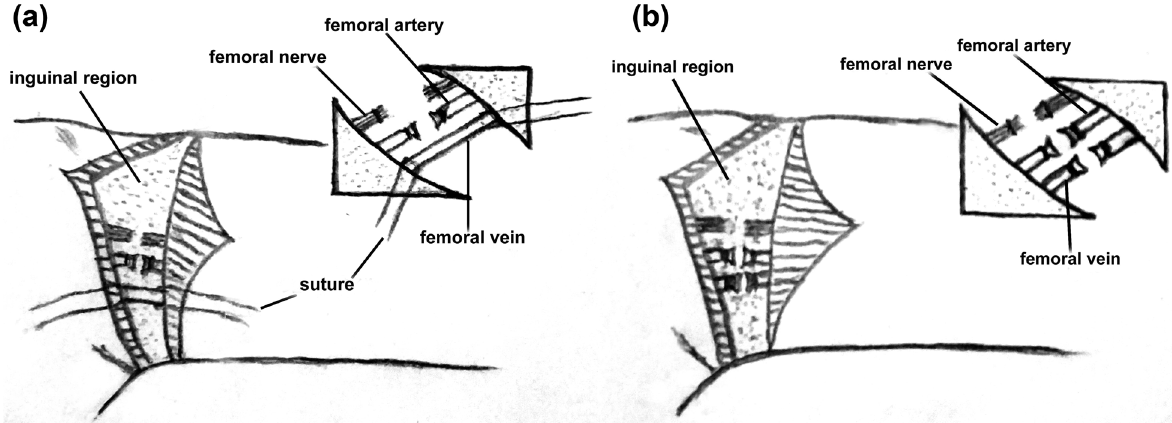
Figure 1: Illustration of ( a ) hip disarticulation with synchronous ligation of the femoral artery and vein and ( b ) hip disarticulation with delayed femoral vein